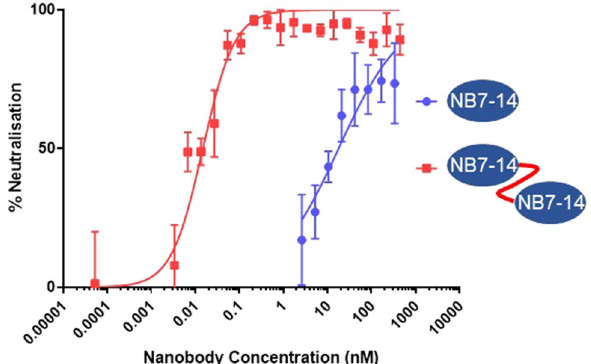
Figure 2. Comparison of neutralisation of H7N9 by monovalent and bivalent NB7-14. Pseudotype micro- neutralisation assay performed using influenza A/Shanghai/02/2013 (H7) HA bearing pseudovirus and mono- and bivalent nanobody NB7-14. Percentage neutralisation is plotted against molar concentration of NB7-14 in two different formats (nM). IC50 for monovalent NB7-14 (17 nM) and for bivalent NB7-14 (130 pM). Neutralisation of A/Texas/50/2012 (H3N2) was negative (data not shown).